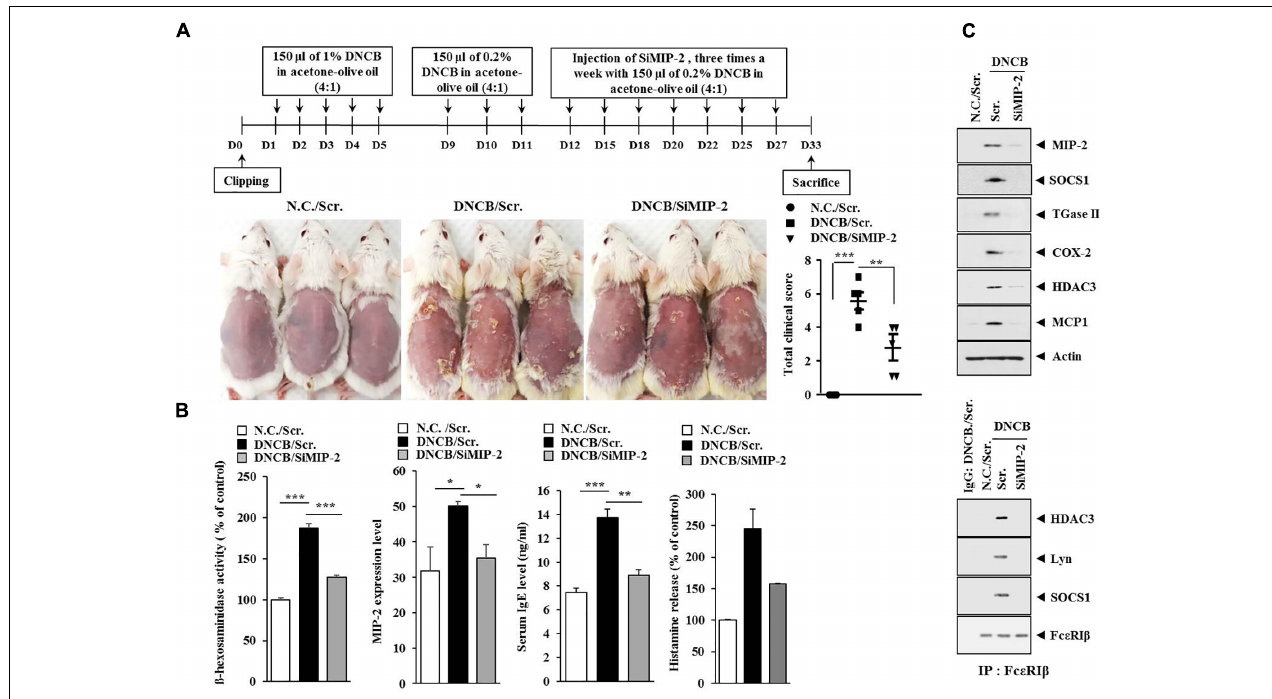
FIGURE 4 | Macrophage inflammatory proten-2 (MIP-2) is necessary for AD. (A) Shows the experimental time line to determine the effect of MIP-2 on AD. Lower figure shows the effect of MIP-2 on clinical symptoms associated with AD. ∗∗ p < 0.005; ∗∗∗ p < 0.0005. (B) Skin tissue lysates were subjected to ß-hexosaminidase activity assay and qRT-PCR analysis. Serum IgE level and the amount of histamine released were also determined. ∗ p < 0.05; ∗∗ p < 0.005; ∗∗∗ p < 0.0005. (C) Tissue lysates from the mice of each experimental group were subjected to western blot analysis and immunoprecipitation by employing the indicated antibody (2 µ g/ml). Tissue lysates from BALB/c mouse injected with scrambled (scr.) following the induction of AD by DNCB were also immunoprecipitated with isotype-matched IgG antibody (2 µ